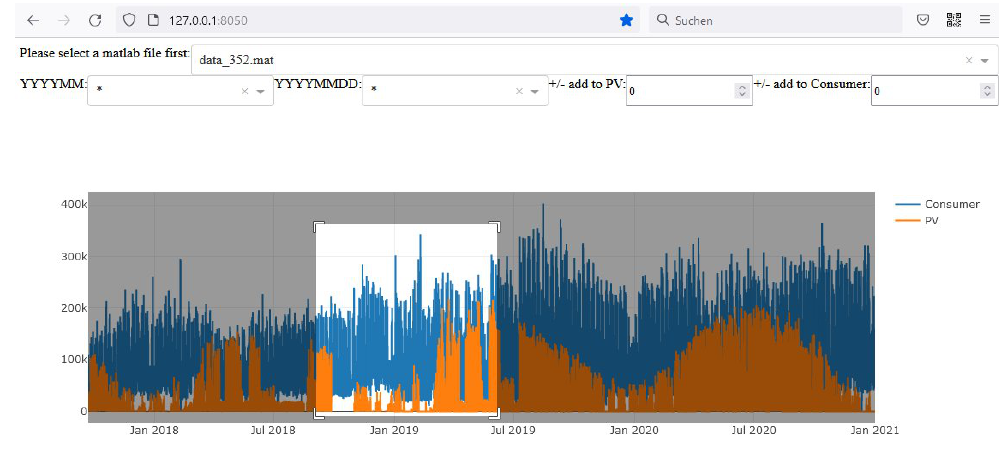
Figure A1. Overview profile extraction